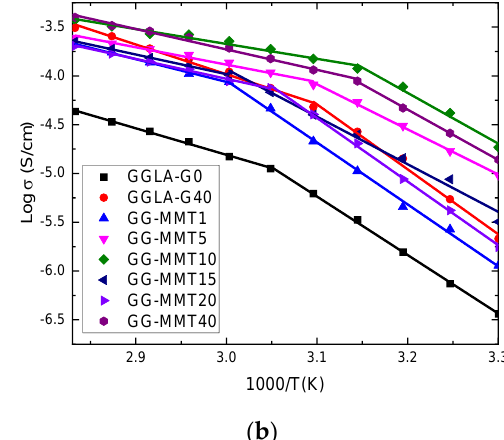
Figure 1. Nyquist diagrams of GGLA-G40 ( a ), GG-MMT10 ( b ) and GG-MMT40 ( c ) samples at tem- peratures ranging from 30 to 80 °C. Inset arrows indicate points outside the semicircle curvature. Figure 2 presents the ionic conductivity values as a function of the inverse tempera- ture for the samples of GGLA-based SPEs and NPEs.